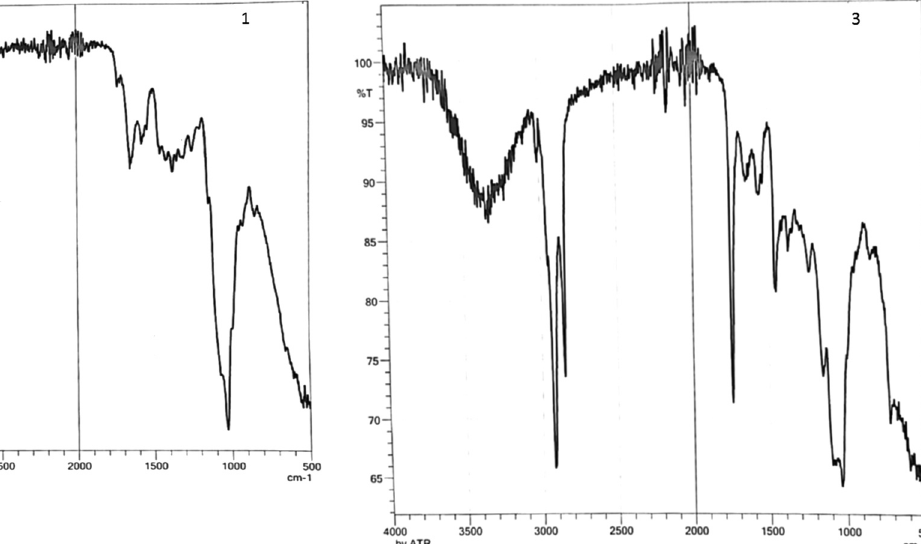
Figure A3: FTIR of fi lm